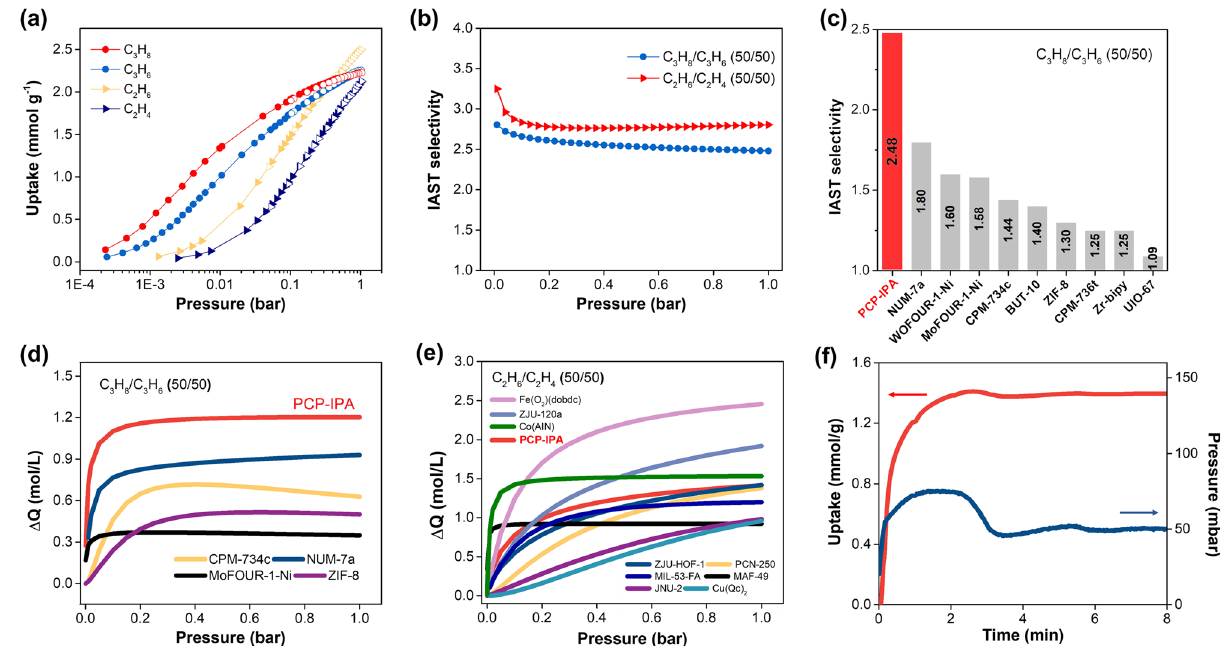
Fig. 2 | The paraf fi n and ole fi n sorption in PCP-IPA. a The C 3 H 8 , C 3 H 6 , C 2 H 6 , and C 2 H 4 adsorptionisothermsat298K; b IASTselectivity( c )comparisonplotofC 3 H 8 / C 3 H 6 (50/50v/v) IAST selectivity among benchmark materials; comparisonof PCP-